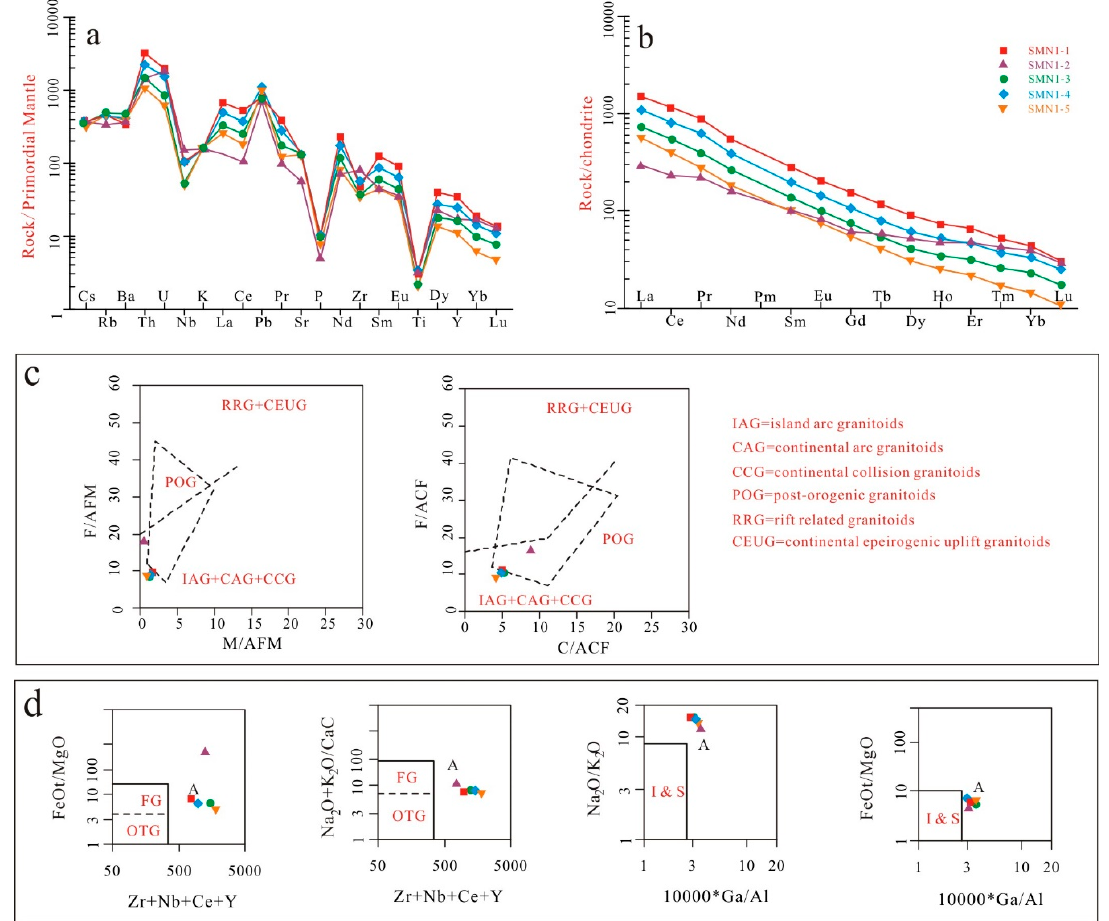
Figure 6. Geochemical classification diagrams for the syenites in the Saima deposit. ( a ) Primitive mantle-normalized trace-element diagram (normalized data from Sun and Mcdonough,1989); ( b ) Chondrite-normalized rare-earth element (REE) patterns (normalized data from Boynton, 1984); ( c , d ) Structural discriminant diagram (after Defant and Drummond, 1990; modified from Pearce 1982) [25–28].